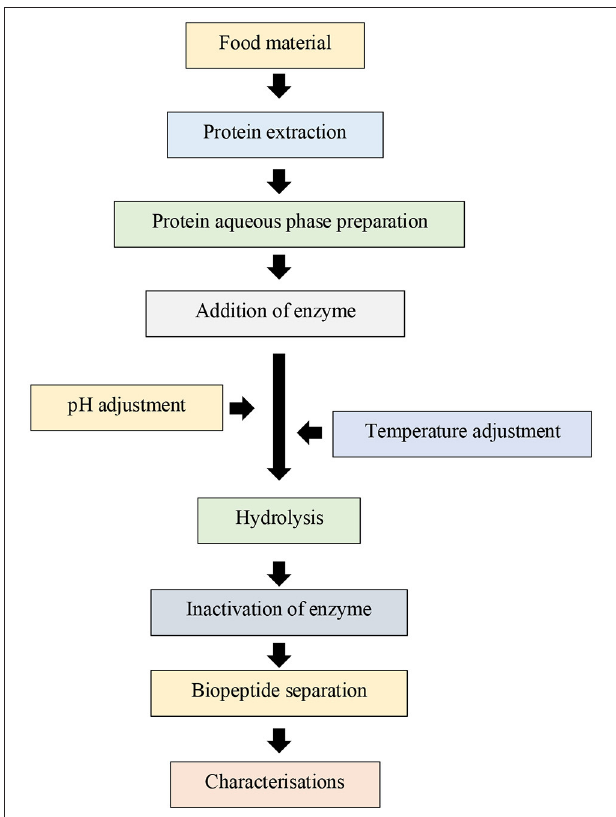
FIGURE 1 | Preparation of biopeptides based on enzymatic hydrolysis of food